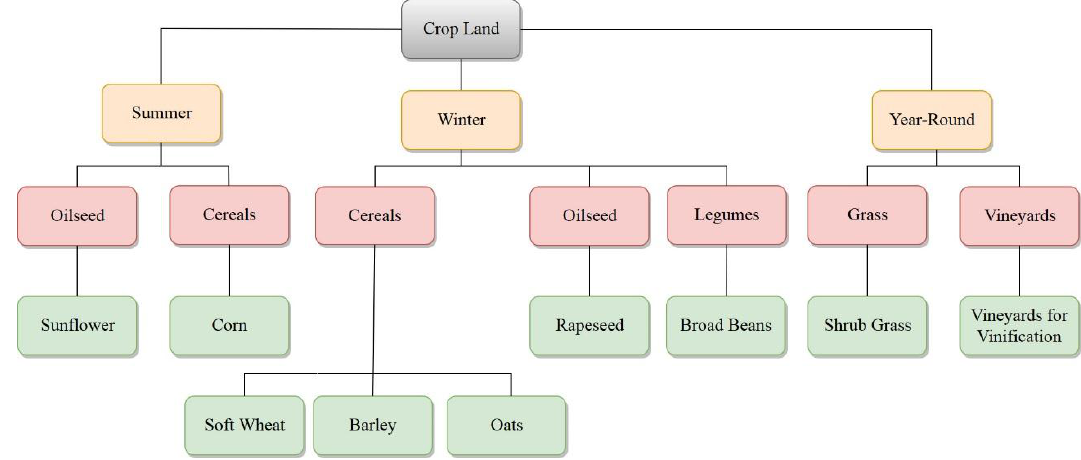
Figure 2. Crop type nomenclature adopted for Navarra, covering the nine main crop types that amount to almost 90% of parcels of the local agricultural zone. Crops are separated based on season, family, and type of cultivation.